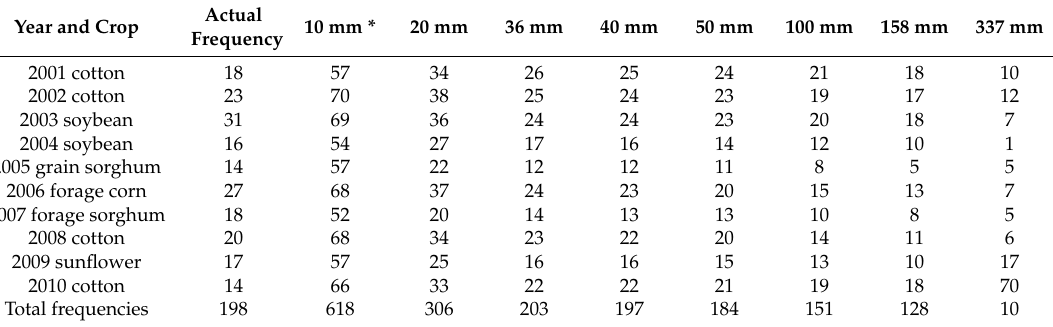
Table 6. Irrigation frequencies (number of times) of actual management and simulated soil water deficit triggers using the auto-irrigation functions in